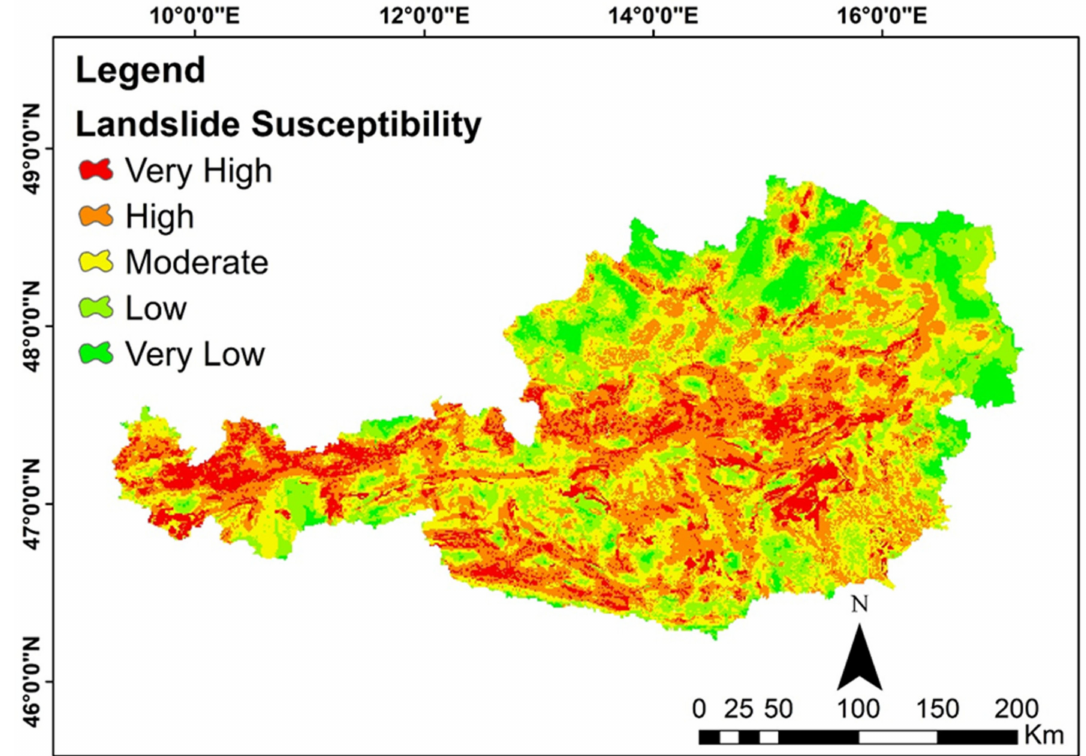
Figure 4. Land susceptibility map for Austria using the FBWM